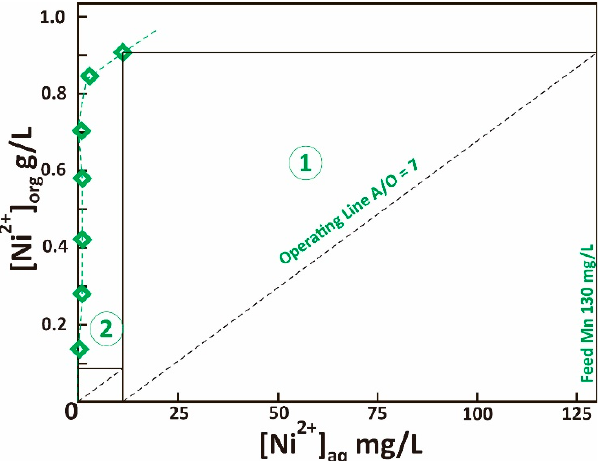
Figure 8. Effect of LIX ® 84-I concentration ( v/v ) on Ni and Li extraction from raffinate (pH 5, metal concentration in feed Ni 0.13 g/L and Li 0.55 g/L).